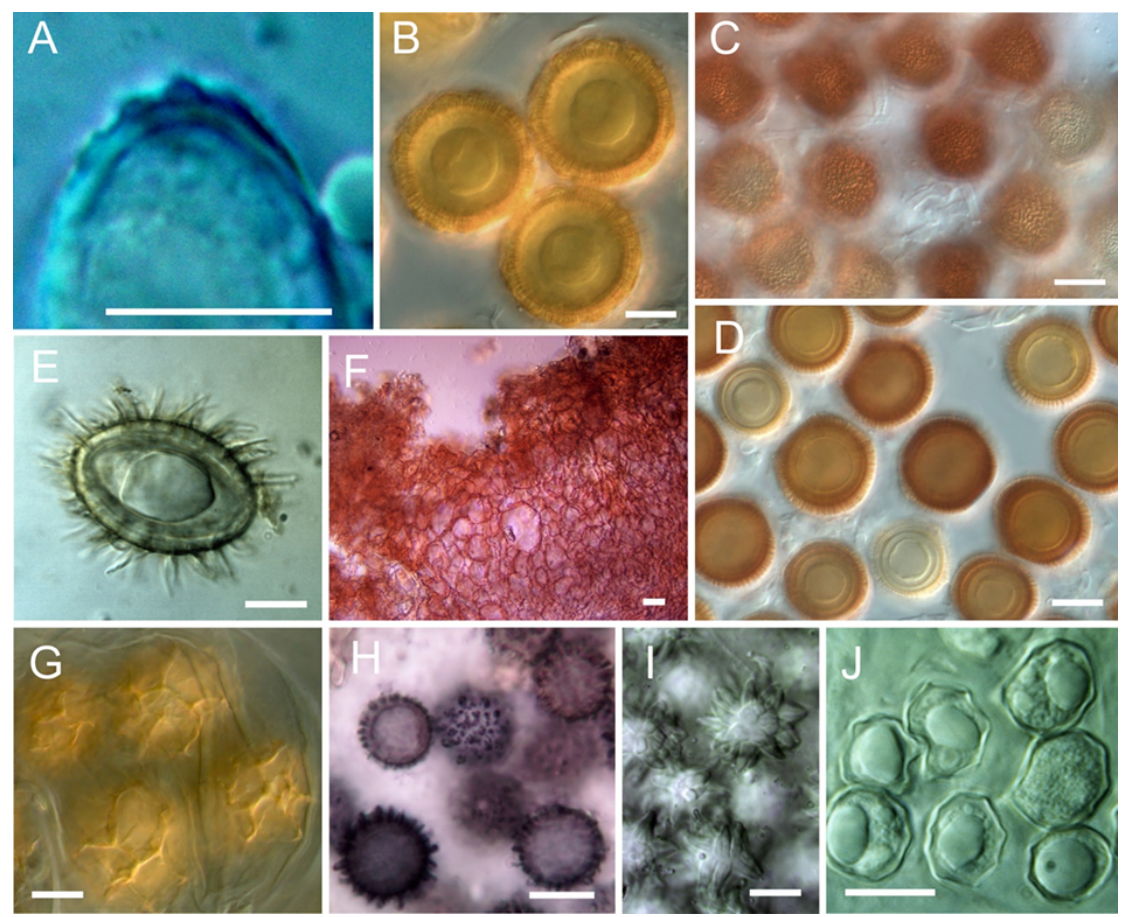
Figure 4 Micromorphological features of selected rare fungi species observed in Cieszyn. ( A ) Spore of Discina martinii . ( B ) Spores of Elaphomyces maculatus . ( C,D ) Spores of E. aculeatus with grainy surface from light microscope: Surface view ( C ) and optical section ( D ). ( E ) Spore of Tuber brumale , covered with dense spines. ( F ) Peridium of T. foetidum ascoma with pseudoparenchymatous structure (stained with Congo red). ( G ) Spores of T. aestivum covered with irregular reticulum. ( H ) Spores of Russula cerea with spiny, amyloid ornamentation. ( I ) Spores of Octaviania lutea with ornamentation in form of pyramidal-conic warts. ( J ) Polygonal spores of Entoloma saundersii . ( A,I,J ) Preparations in KOH; ( B–E,G,H ) stained in Melzer’s reagent. Scale bars: 0 µ m. Photographs by P.